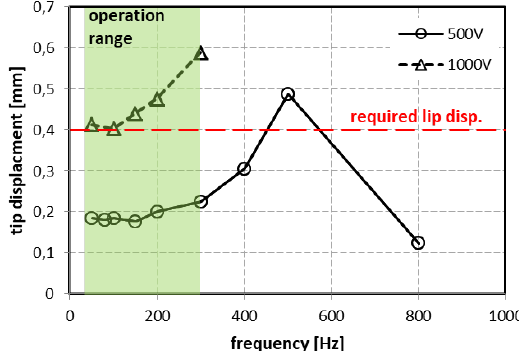
Figure 11. Lip displacement at different frequencies and actuation voltages at a plenum pressure of one bar.